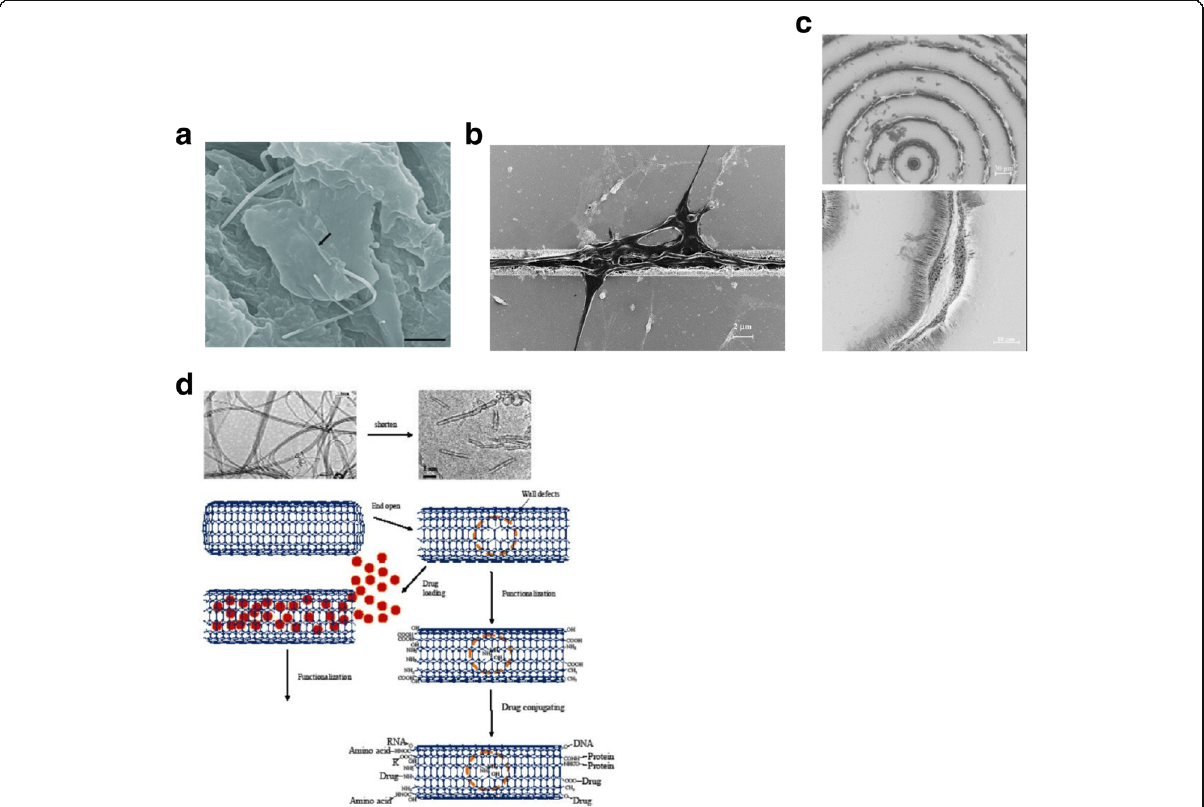
Fig. 45 a SEM image of bone-tissue sections observed 4 weeks after CNTs were implanted into tubal defects in mice. Adapted from [295]. b , c SEM images showing guided neurite growth along the MWCNT array pattern. The bottom image in part ( c ) represents the magnified view of a selected region in the top image. Adapted from [296]. d Schematic of steps showing CNT-based drug delivery systems. CNTs of various lengths were used as drug carriers by making their ends open and allowing the drug to be loaded for targeted drug delivery. Adapted from